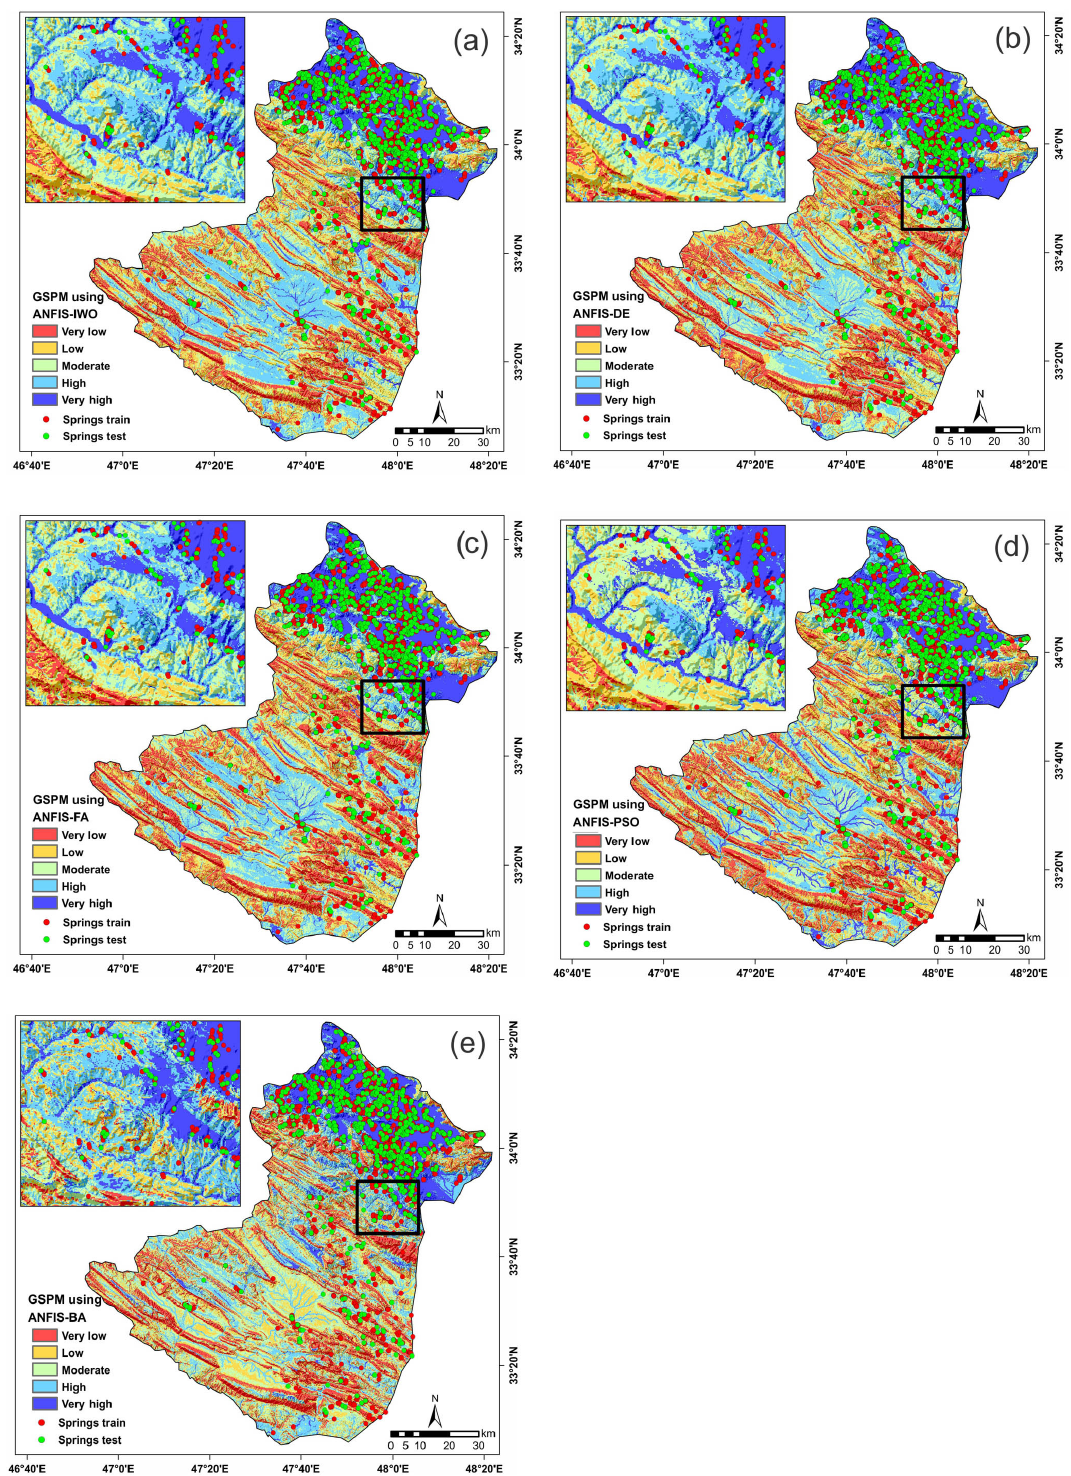
Figure 9. Groundwater spring potential map using (a) the ANFIS–IWO model, (b) the ANFIS–DE model, (c) the ANFIS–FA model, (d) the ANFIS–PSO model, and (e) the ANFIS–BA